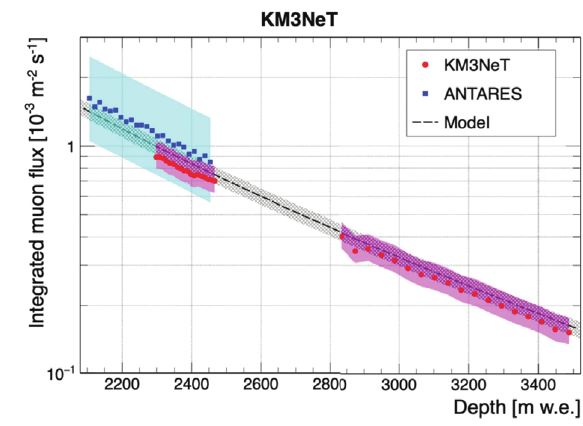
Figure 4: Integrated atmospheric muon flux as a function of depth below the sea level (expressed in meter of wa- ter equivalent) measured with ORCA1 and ARCA2 de- tectors, red points. Bugaev model is reported with black dashed line. ANTARES data are also included as blue point for comparison. Systematic uncertainties are re- ported as shadowed